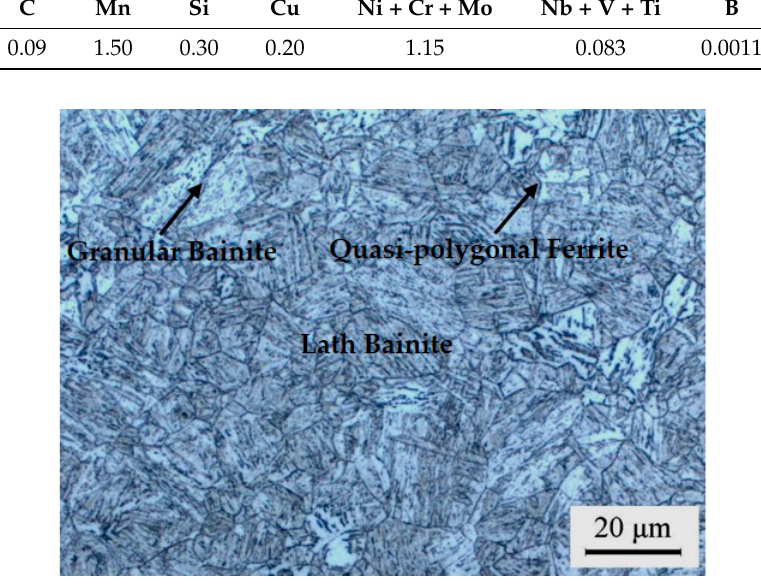
Figure 1. The microstructure of the experimental steel.